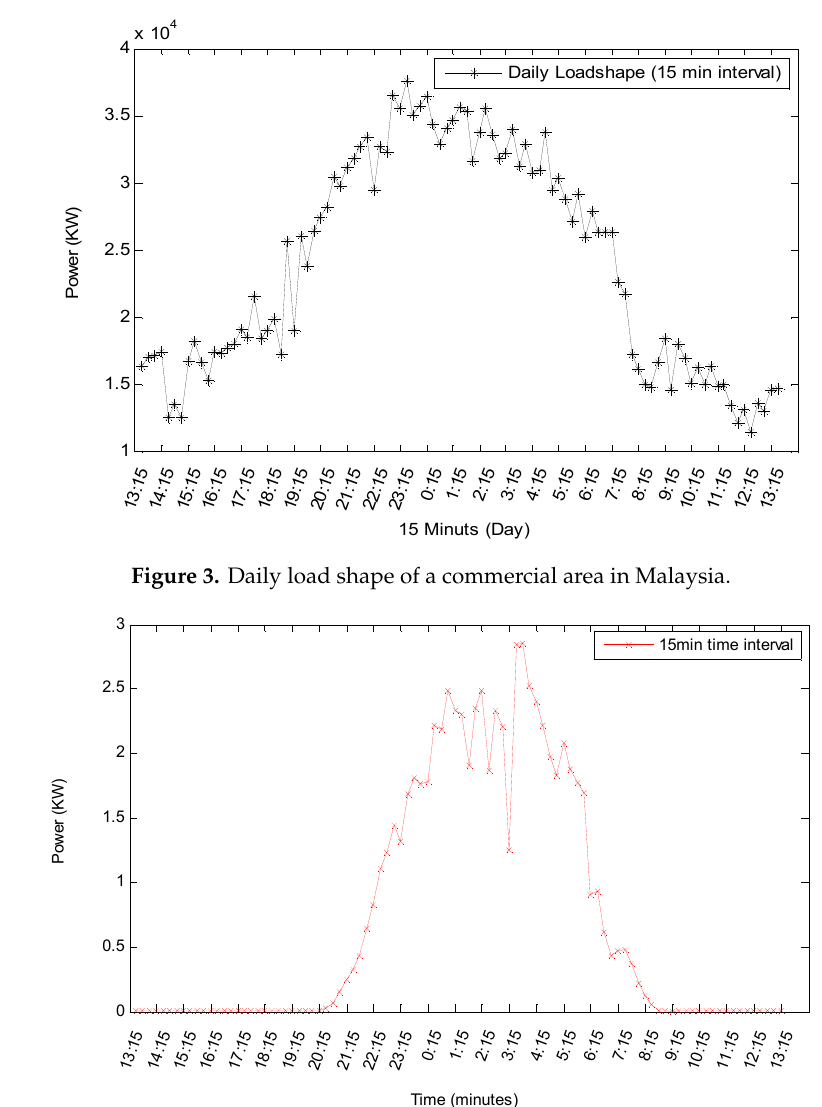
Figure 4. Photovoltaic (PV) generation output power of Universti Kebangsaan Malaysia (UKM) solar system.